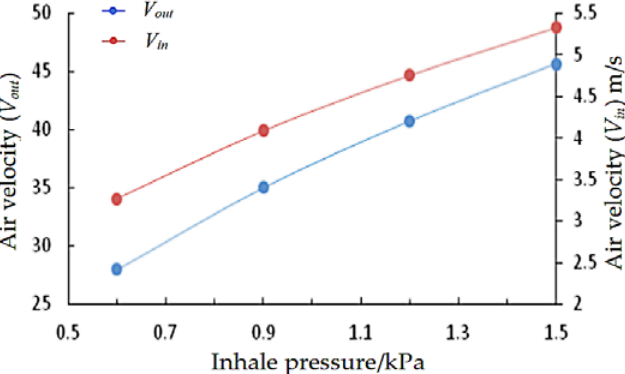
Figure 23. Motion trajectory of the paint mist in different inhale pressure. According to the calculation, the wind speed of the suction surface of the recovery hood can be calculated to increase from 27 to 45.3 m/s. The average wind speed of the inlet surface of the recovery hood at 0.9 kPa is the same as the air phase flow speed at the free spraying state. As the power of the suction pump increases, the negative pressure at the outlet of the